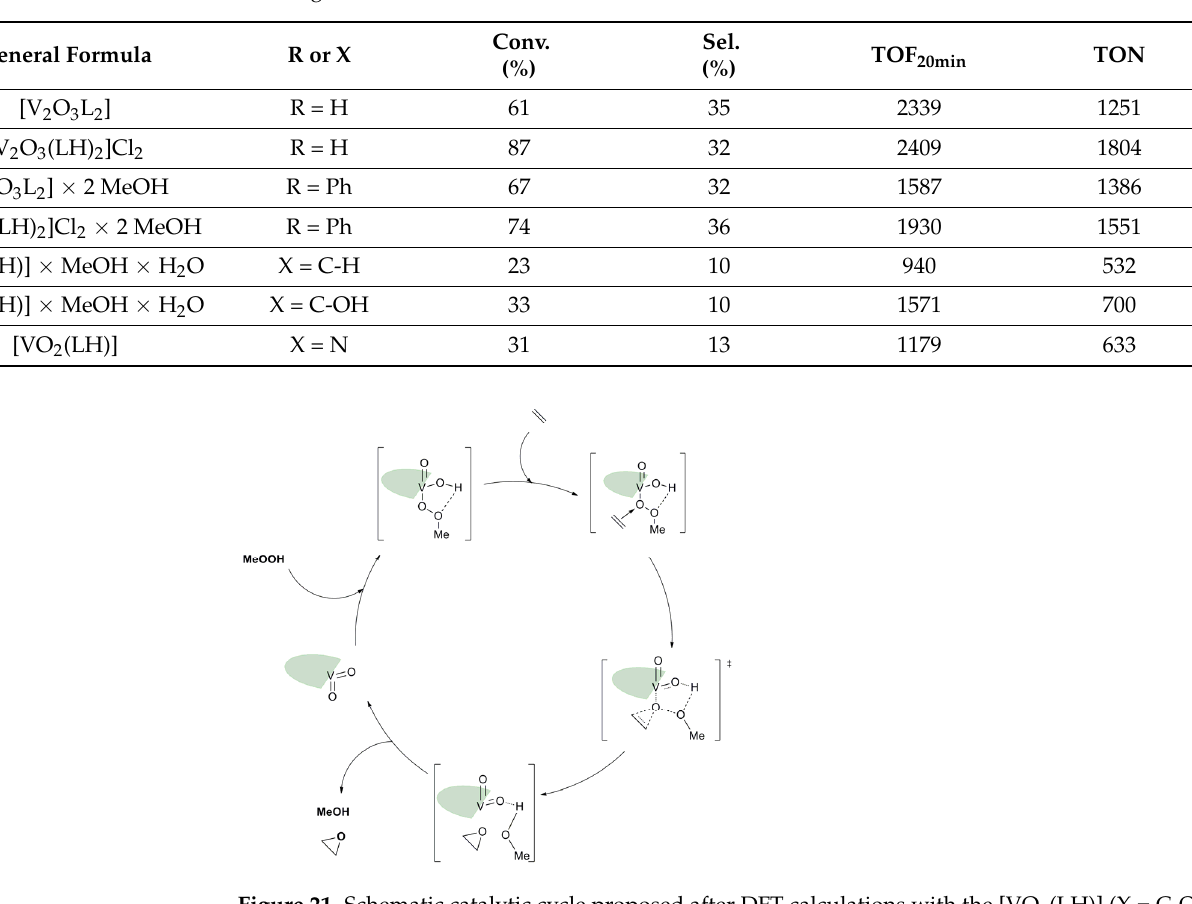
Figure 20. Schematic representation of vanadium complexes containing pyridoxal fragments being monomeric when containing hydrazide moieties and dimeric with thiosemicarbazones. Table 10. Results of CO epoxidation under organic solvent-free conditions with vanadium complexes from Figure 20.